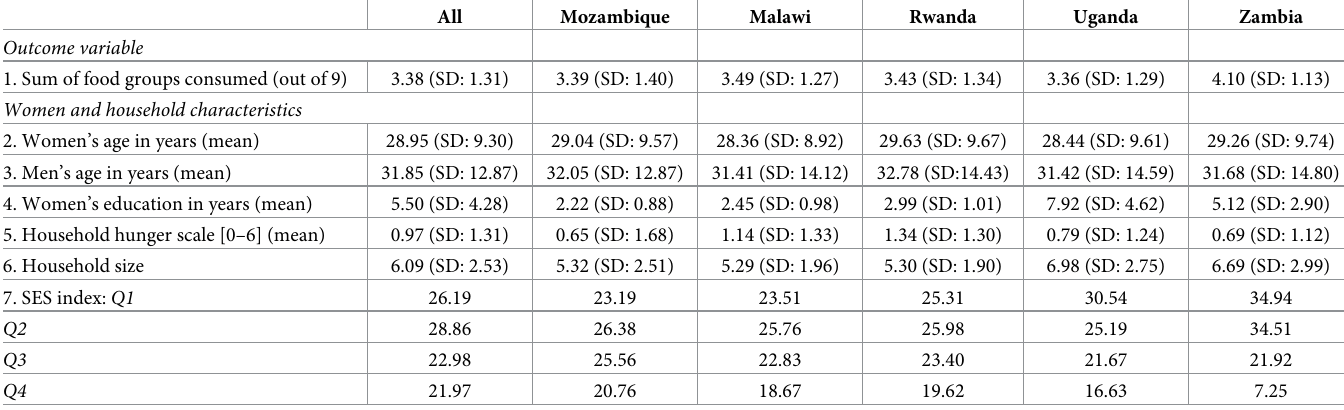
Table 2. Sample characteristics (percentages, except where otherwise specified). All Mozambique